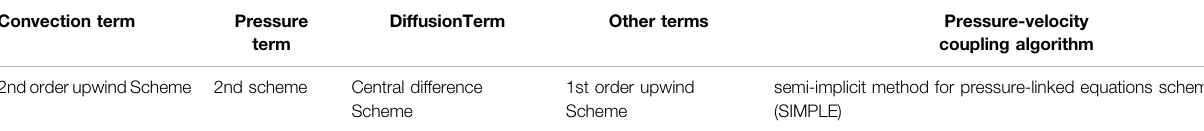
TABLE 4 | Discretization method for the governing equations. Convection